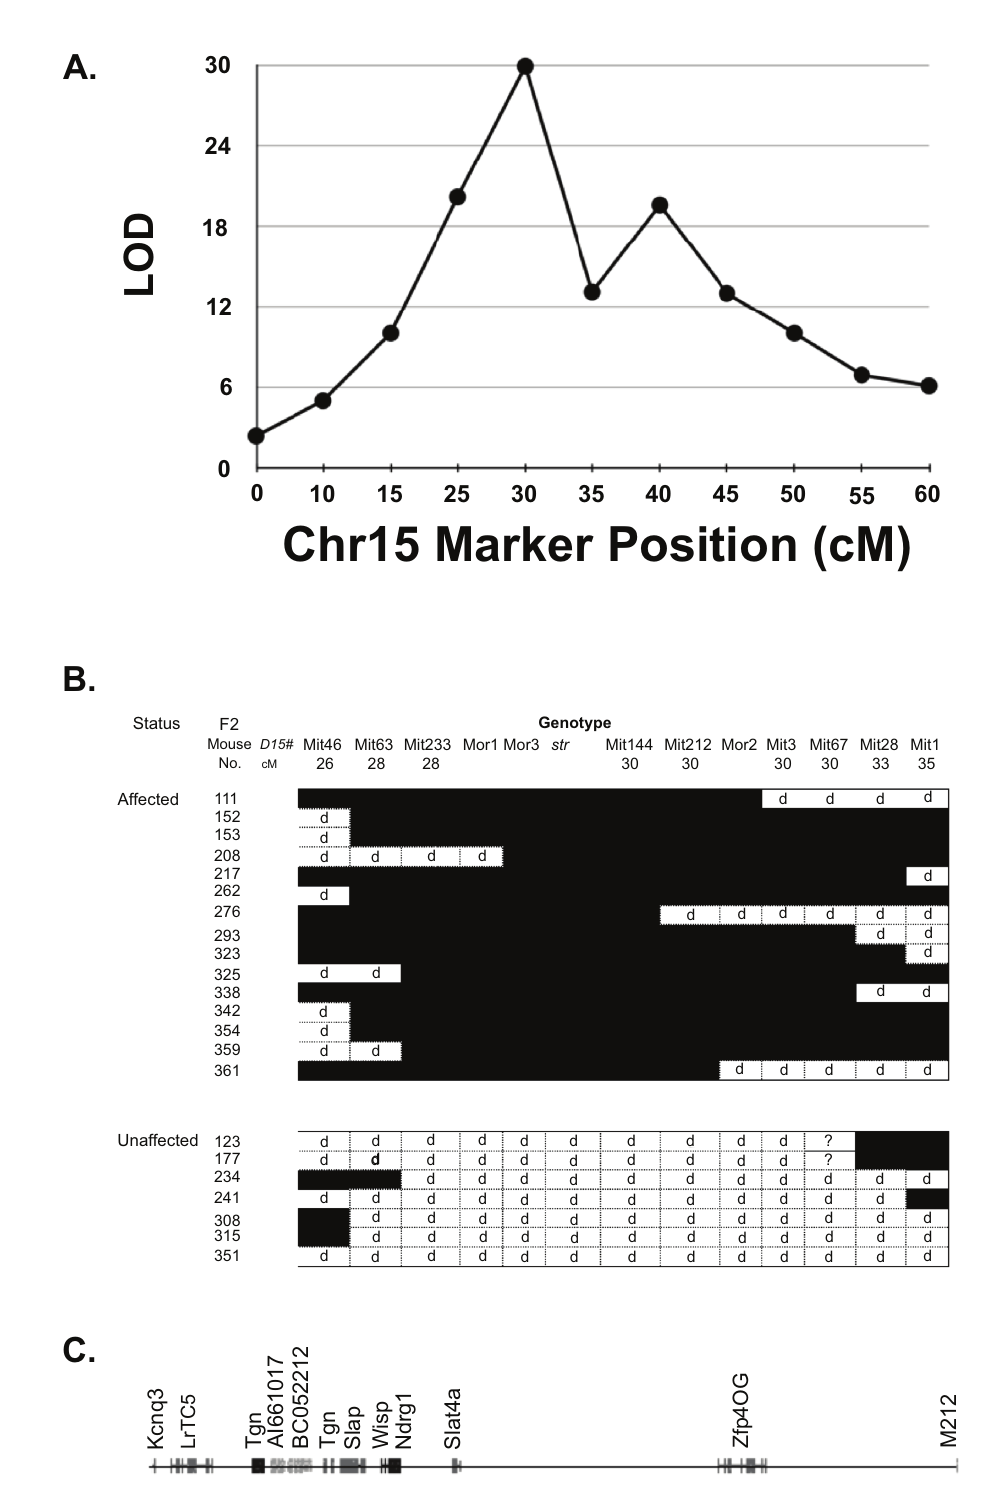
Figure 3. Fine mapping of str mutation. A . Affected F2 mice were typed with markers on chromosome 15 and LOD scores calculated as in Figure 1. B. Affected and unaffected mice which had recombinations within 5 cM of the peak of linkage were genotyped with additional markers. “ Mit ” denotes D15Mit markers, with their given positions in cM; “ Mor ” denotes novel D15Mor markers developed here (see also Table 1). Filled squares = homozygous for allele derived from the NOD. str strain; d = at least one copy of DBA/2 allele. C. Genomic map of chromosome 15 between the flanking markers D15Mor1 (which is in an intron of Kcnq3 ) and D15Mit212 , from 66.1Mb to 68.5 Mb of the UCSC October 2007